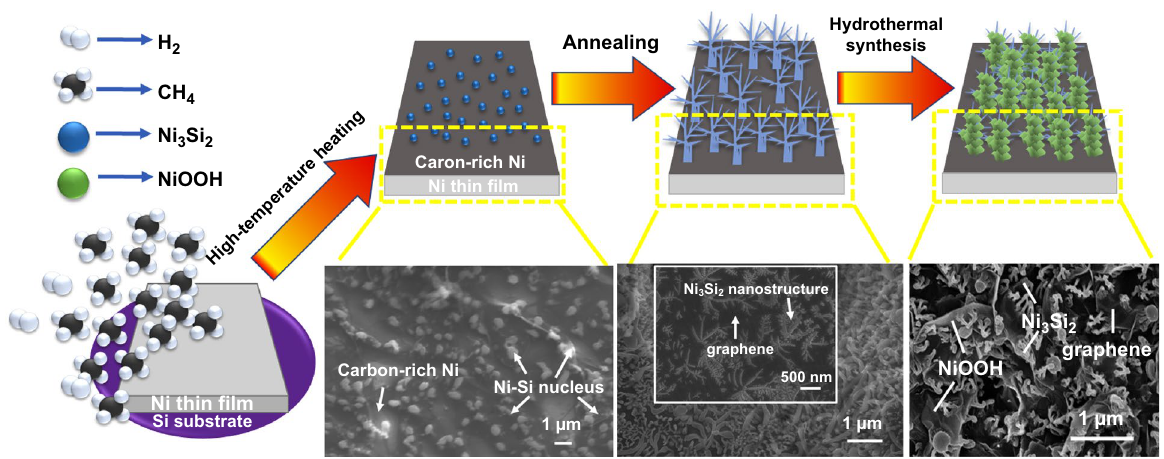
Fig. 1 Schematic diagram of the formation and evolution of creeper-like